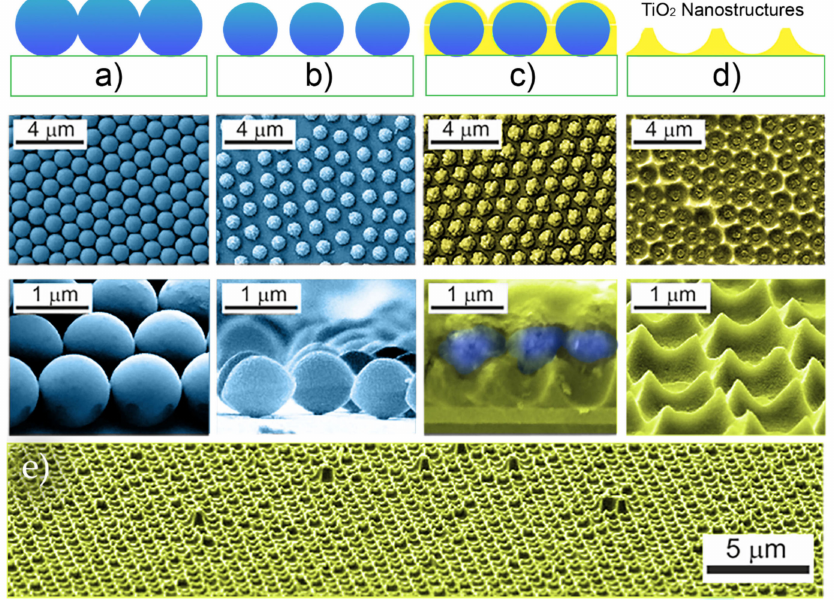
Figure 11. Schematic drawings and SEM pictures of the samples obtained after the different steps of the TiO 2 nanostructure construction via CL on glass substrates: ( a ) a hexagonal array of colloidal PS spheres is patterned on the cell front, ( b ) O 2 dry etching, ( c ) TiO 2 is deposited, filling the inter-particle spaces, ( d ) the spheres are removed leaving an array of semi-spheroidal void-like features. The final TiO 2 structure ( e ) uniformly covers the entire sample area. Adapted with permission from [33]. Copyright 2021 The Royal Society of Chemistry.